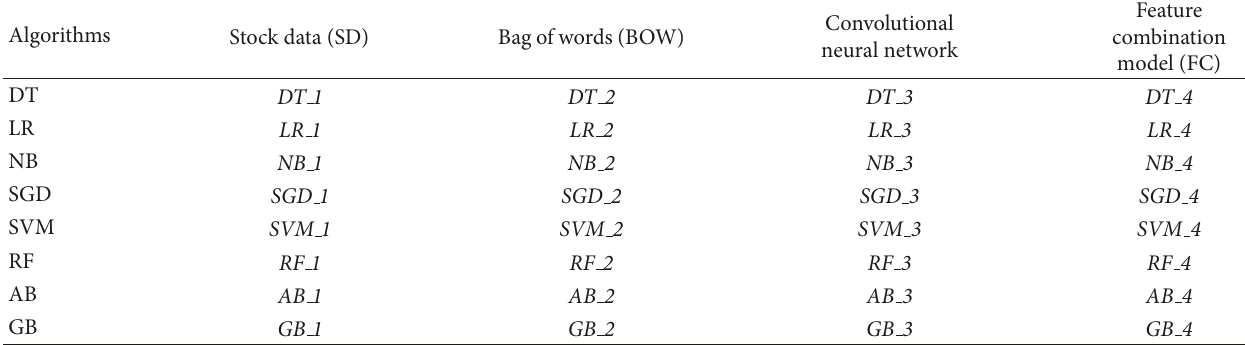
Table 8: Abbreviations of the results for each algorithm